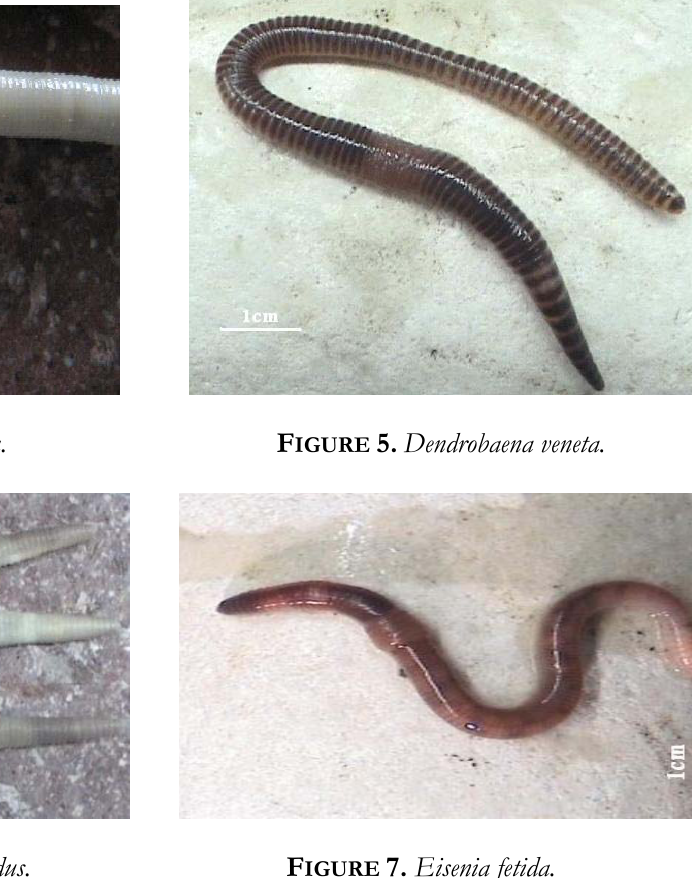
F IGURE 6. Dendrodrilus rubidus. F IGURE 7. Eisenia